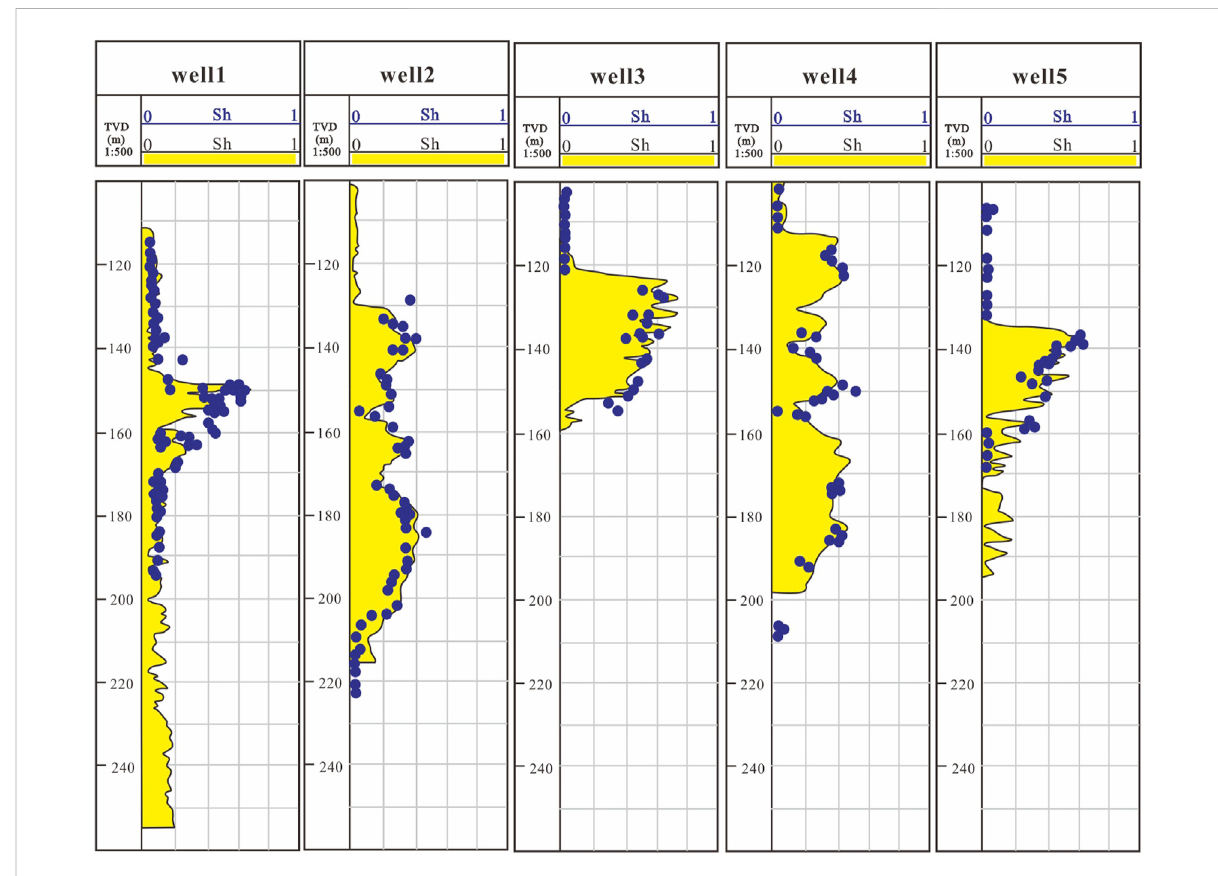
FIGURE 5 Comparison between calculation results of two-parameter saturation model and core experimental data of fi ve wells in the study